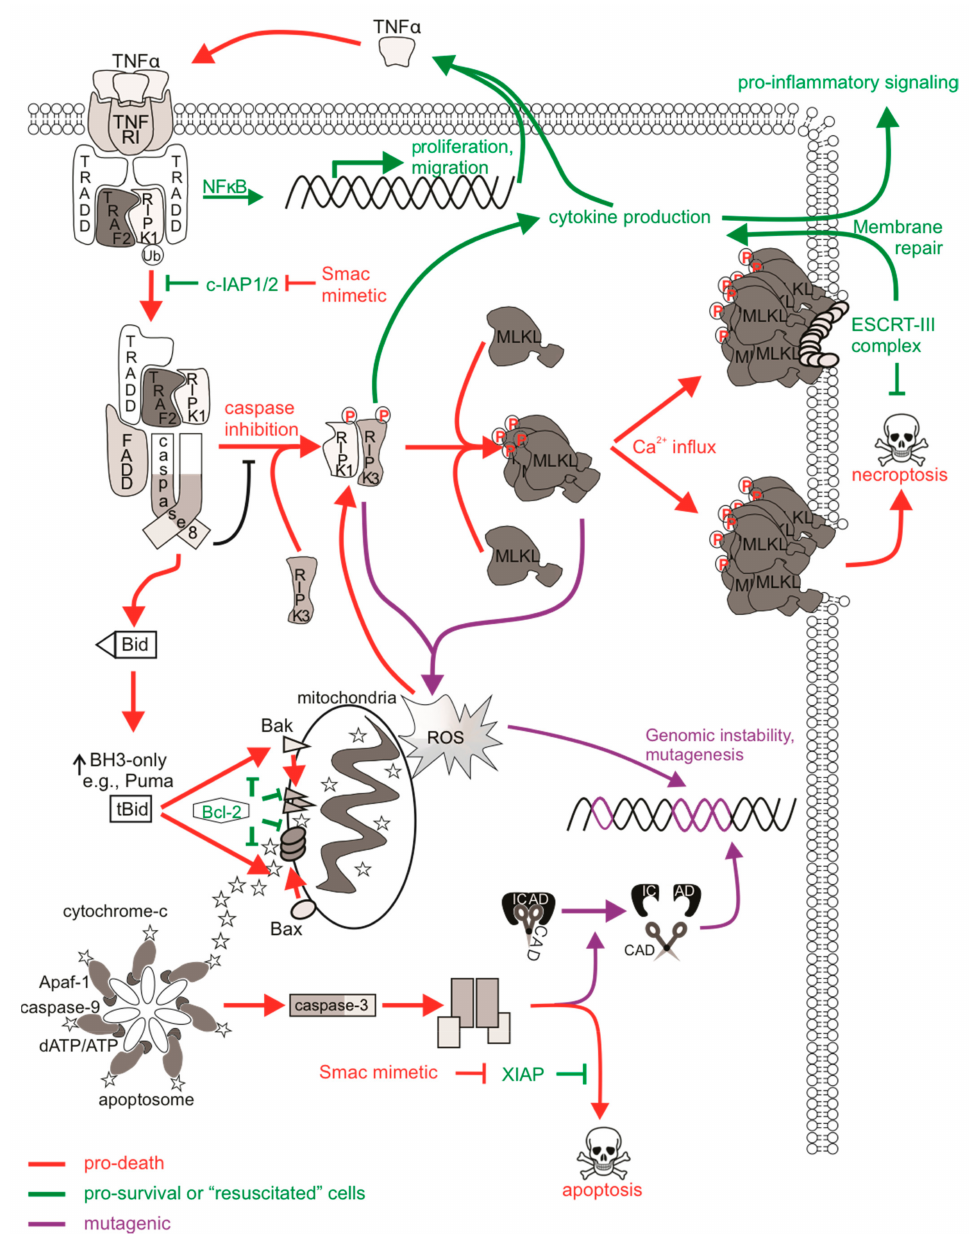
Figure 2. The mutagenic potential of necroptotic signaling. cIAP1/2 acting at TNFR1 complex I polyubiquitinates RIPK1 to allow for NF κ B transcription and expression of proliferative and migratory genes. Some cells can autocrine produce TNF α to further stimulate TNFR1 signaling. There is a transition to pro-death complexes IIa (if caspase-8 is present) or IIb (if caspase-8 activity is inhibited) upon incapacitation of cIAP1/2. Pro-apoptotic ripoptosome formation leads to MOMP and caspase activation, which can provoke mutations via CAD-dependent DNA damage. The pro-necroptotic necrosome is formed in cells lacking caspase-8 activity allowing RIPK1 recruitment of RIPK3, the autophosphorylation of RIPK3, and the subsequent phosphorylation and activation of MLKL by RIPK3. Activated MLKL oligomerizes then translocates to the plasma membrane, where it forms pores to compromise membrane integrity. The ensuing MLKL-mediated necroptotic death is not associated with DNA damage. The initiation of ESCRT-III-mediated membrane repair of MLKL pores delays the onset of or even prevents necroptotic cell lysis and allows for RIPK3-dependent cytokine production and release. Survival following necroptotic signaling is known as “resuscitation”. The necrosome can also stimulate mitochondrial-dependent or independent ROS production, which can stabilize the RIPK1/RIPK3 necrosome as a positive feedback loop. DNA can be directly impacted by ROS, and mutagenesis might occur if damage is mis-repaired or there is sustained genomic instability in “resuscitated”